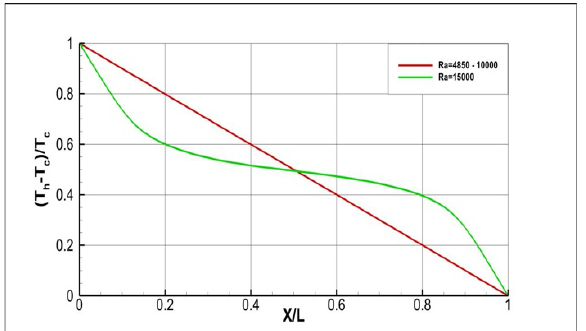
Fig. 5. The linear temperature